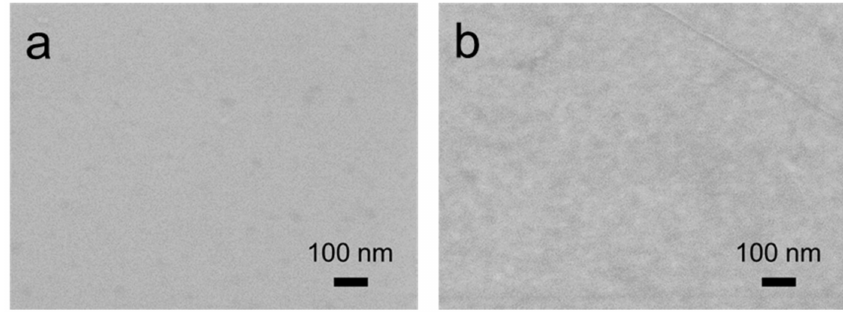
Figure 6. FE-SEM images of ( a ) graphene and ( b ) OG-20.